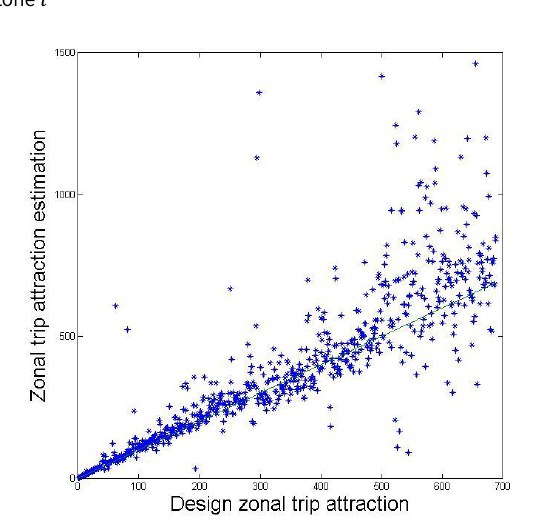
Figure 6. Zonal trip attraction pattern comparison